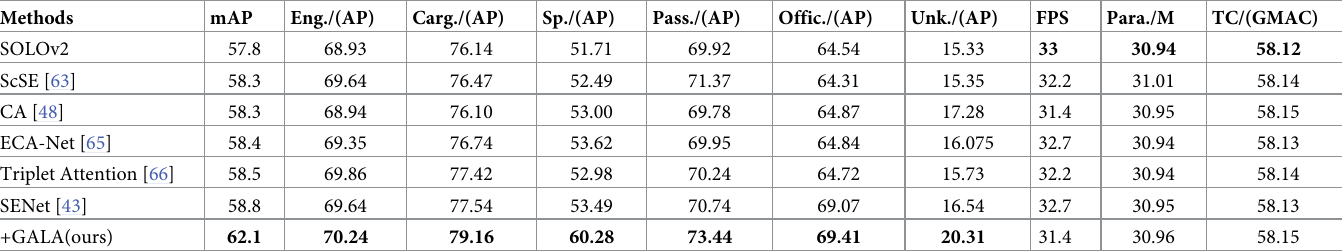
Table 6. The performance of different attention mechanisms on